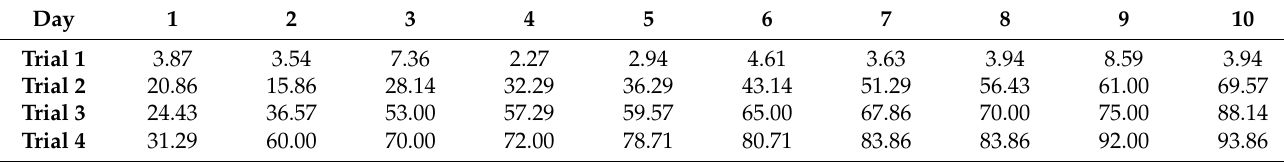
Table A3. Distance time warping non-linear (elastic) alignment distance results for all trials’ red versus green plots using day-0 control images specific to each trial. Values are represented as percentage DTW difference relative to a 7 × 10 6 -pixel